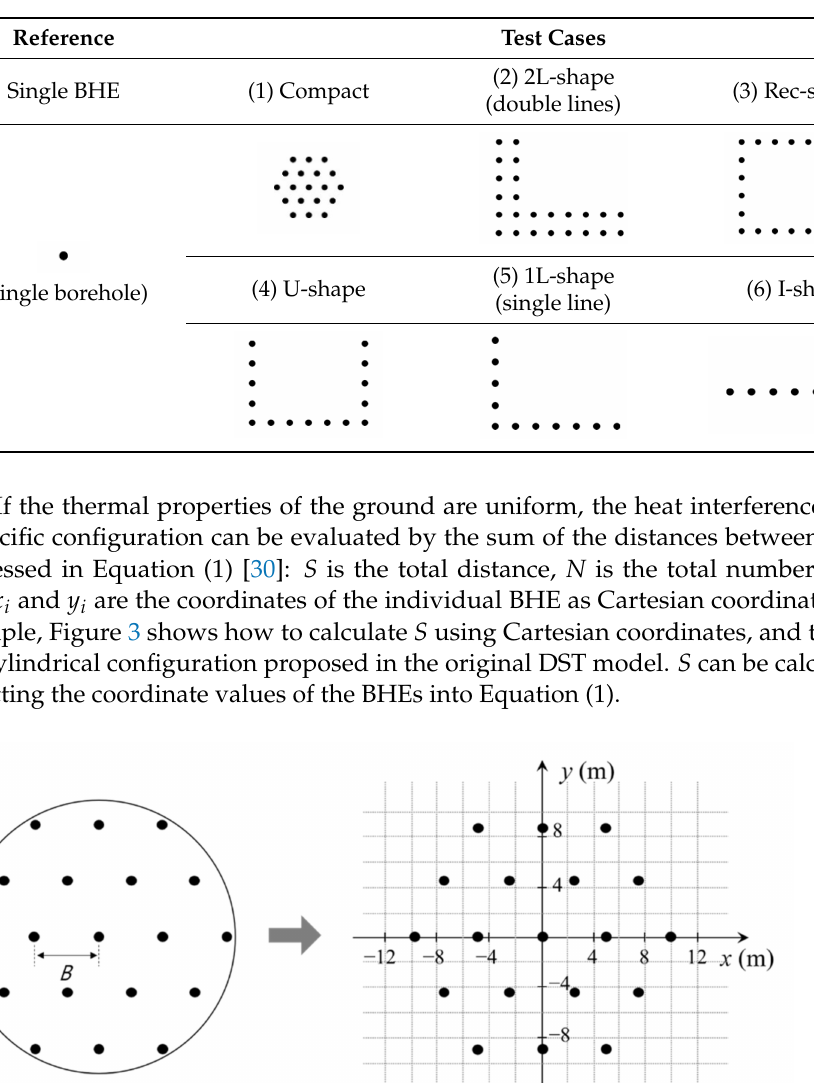
Table 1. Selected bore field configurations for tests.